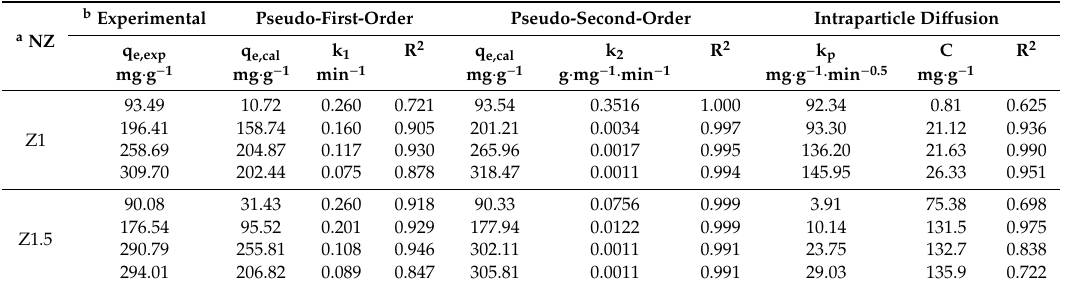
Table 3. Kinetic parameters of copper removal from aqueous solutions onto synthetic